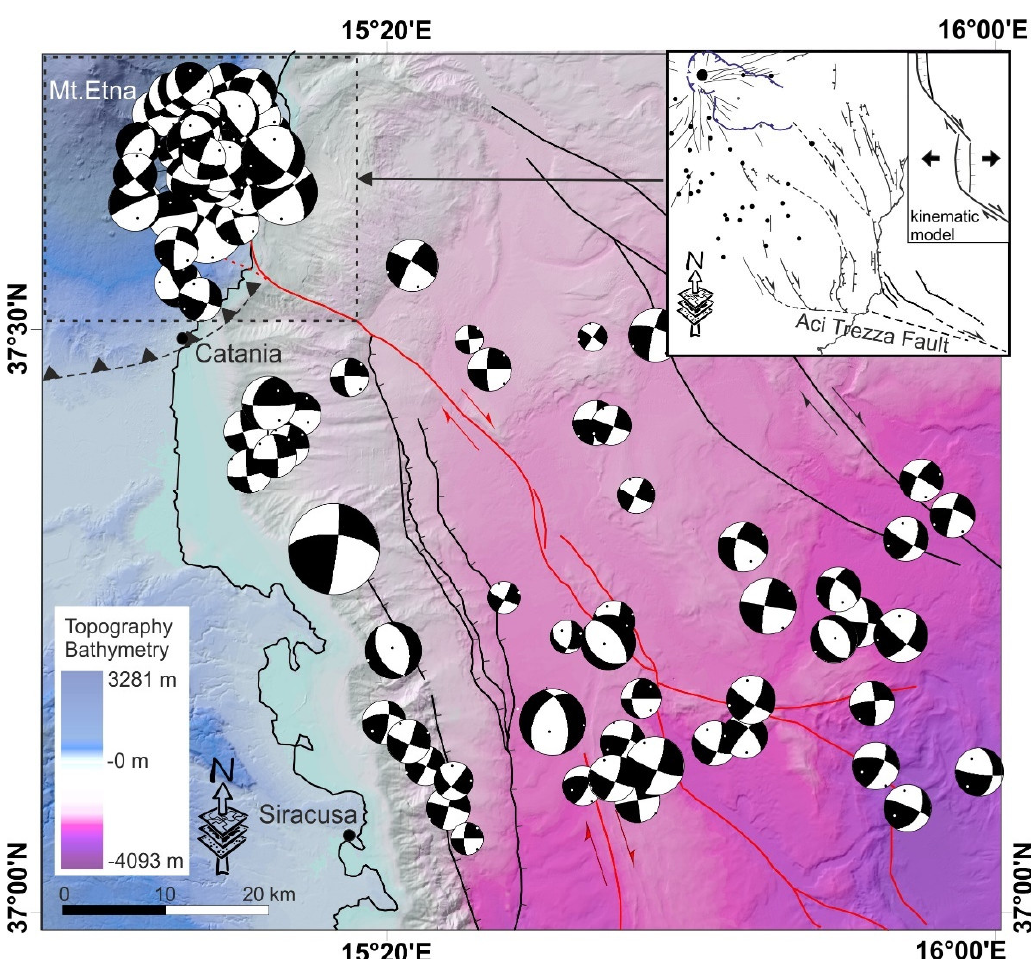
Figure 13. Seismotectonic map of the western Ionian Sea and Mt. Etna area. The Alfeo–Etna faults (after [9,10,47]) are red colored (see Figure 1 for location). Inset shows the kinematic interpretation of the volcano-tectonic structures (see Figures 1 and 2 for the legend) occurring in the eastern sector of Mt. Etna in the framework of the Alfeo–Etna shear zone (releasing sectors, see [84,88–90]).